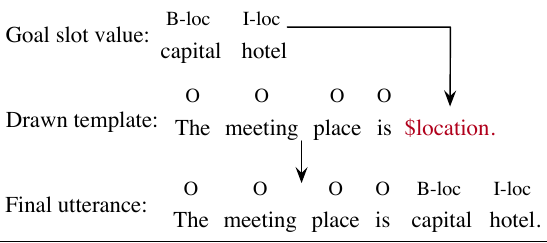
Figure 2. An example of user utterance